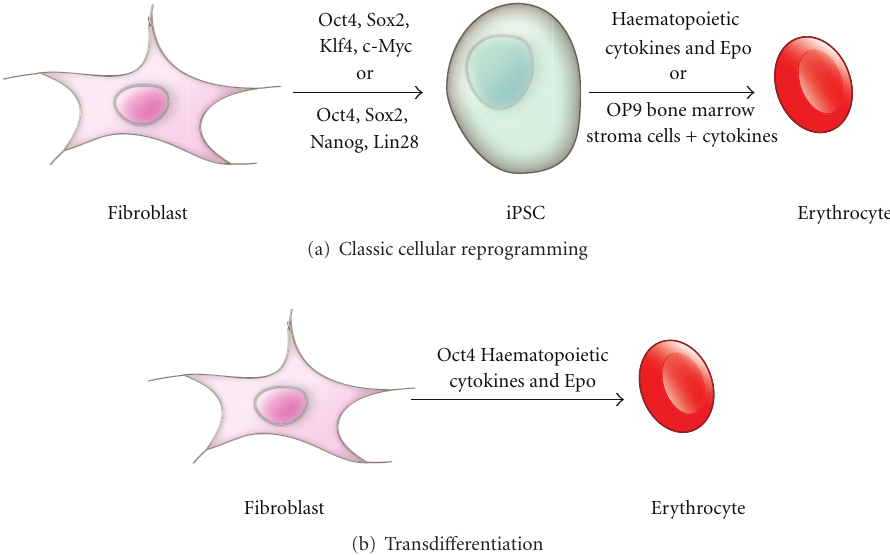
Figure 1: Diagrammatic representation of cellular reprogramming compared to transdi ff erentiation in the development of erythrocytes. (a) Fibroblasts cells can be reprogrammed into pluripotent cells through the introduction of various exogenous factors. From this induced pluripotent state, these cells can be either cultured with various cytokines supporting erythrocyte di ff erentiation and growth, for instance, IL-3, IL-6, and Erythropoietin (Epo) or cultured with OP9 bone marrow stroma cells to di ff erentiate into erythrocytes. (b) Fibroblasts cells can be reprogrammed directly into erythrocytes through the introduction of Oct4 and culturing with Epo in conjunction with other haematopoietic